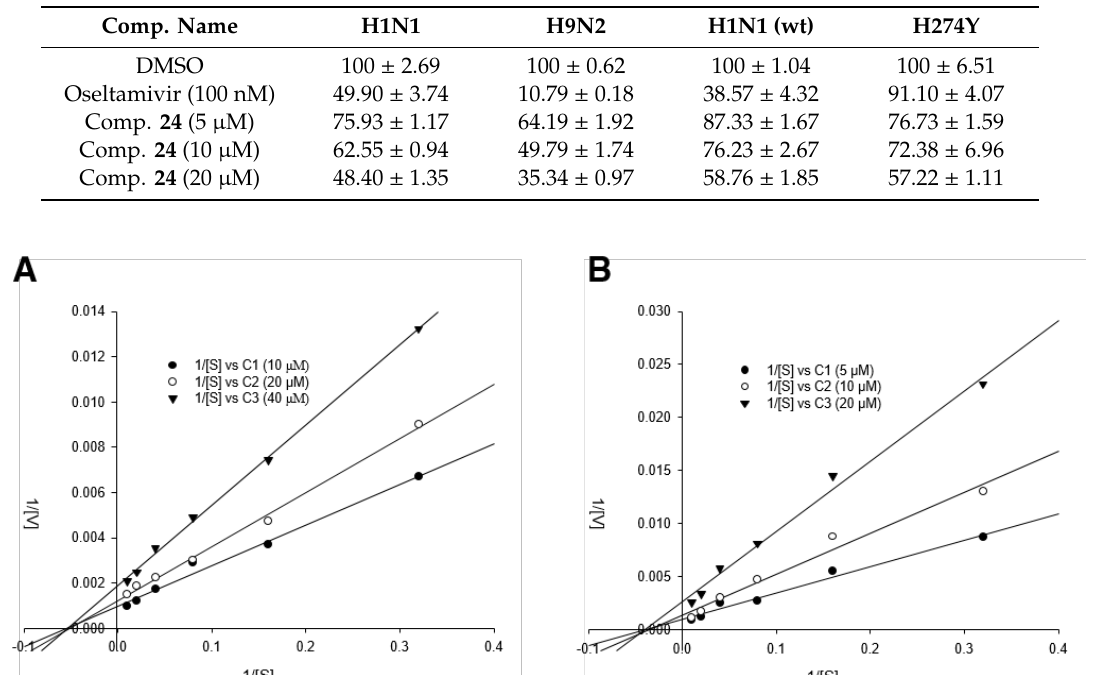
Table 2. Percent influenza NA activity (compared with DMSO as a control).